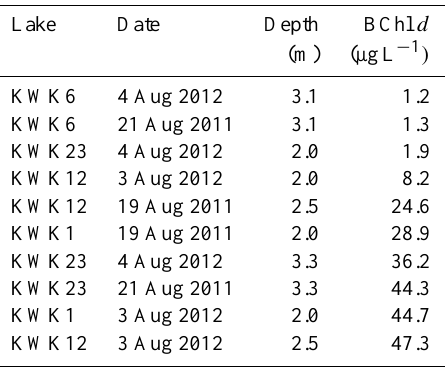
Table 3. The relative concentration of bacteriochlorophyll d (BChl d , µgL − 1 ) based on chromatogram peak area at 430nm. The KWK thaw sites have been arranged from lowest to highest concen- trations of